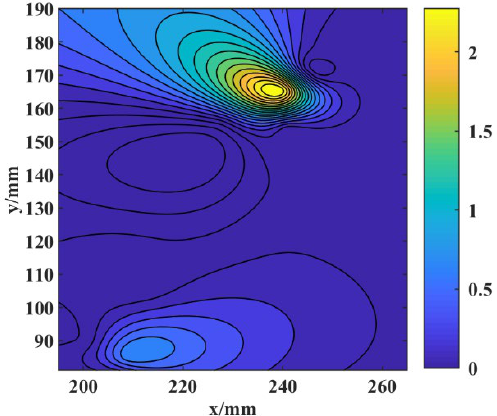
Figure 7. Distribution diagram of stiffness index.